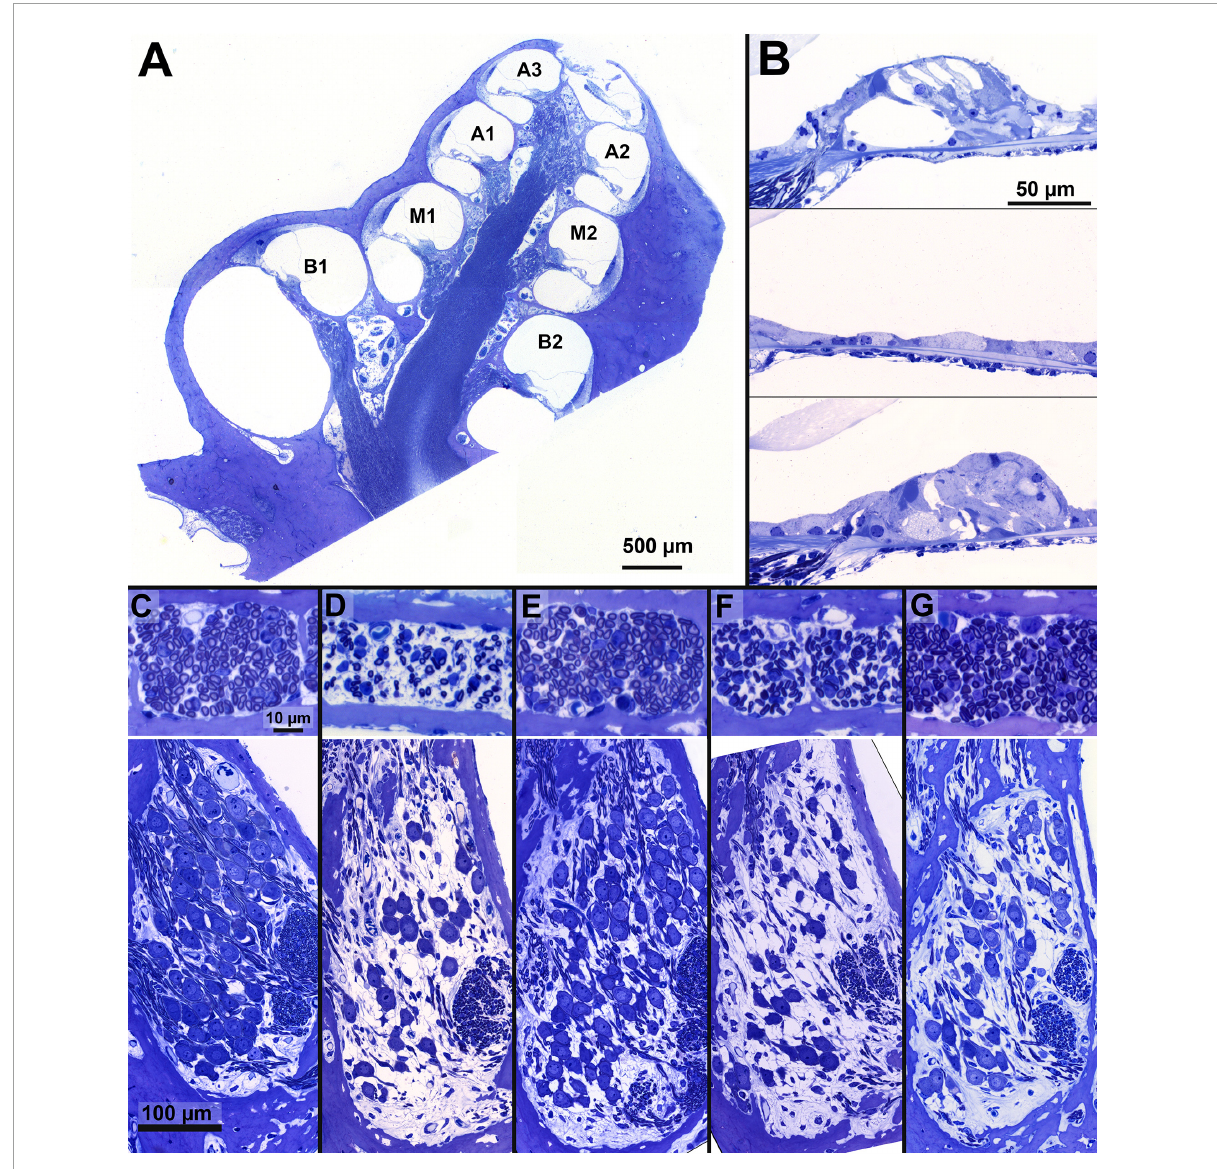
FIGURE2 Examples of cochlear micrographs. (A) A cross-section of a guinea pig cochlea along a midmodiolar plane, with the seven cochlear locations (semi-turns), B1-A3 from base to apex. (B) Examples of the organ of Corti containing the cochlear hair cells, with an NH example (top, M1), and two examples following ototoxic deafening: a completely degenerated (middle, M1) and a collapsed and degenerating organ of Corti (bottom, M2). (C–G) Examples of a cross-section of peripheral processes in the osseous spiral lamina of the basal turn (in between B1 and B2; top) and Rosenthal’s canal from the upper basal turn (B2) containing the SGC somata (bottom) from a single animal per group, with a normal-hearing example in panel (C) . The average PP and SGC survival relative to NH, of the examples are given in percentages: (D) PBS: SGC 49%, PP 37%; (E) BDNF-treated: SGC 65%, PP 81%; (F) NT-3-treated: SGC 37%, PP 75% and (G) a Cocktail-treated animal: SGC 78%, PP 85%.